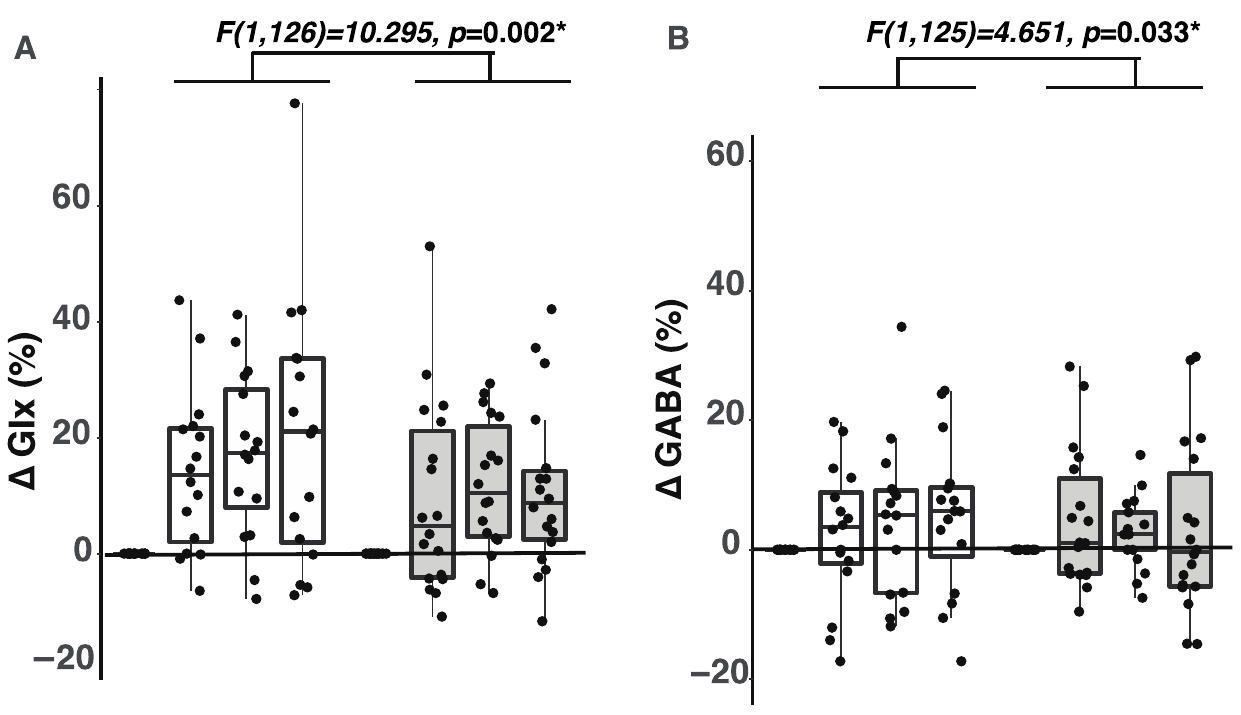
Figure 1. Task-related changes in Glx and GABA content. Open white bars represent the CONTROL group and grey bars represent the ADHD group. In each group, three bars are shown as ΔGlx or ΔGABA increases in the auditory, Stroop, and Flanker tasks respectively. ( A ) Glx changes during the tasks (ΔGlx) are shown in percentage. ΔGlx were computed using the following formula: ΔGlx = (Glx task - Glx non-task )/Glx non-task × 100%. ( B ) GABA changes during the tasks (ΔGABA) are shown in percentage. ΔGABA were computed using the following formula: ΔGABA = (GABA task - GABA non-task )/GABA non-task × 100%. In both figures, dots represent the data points from individual subjects. The upper boundary of an individual box represents the 75th percentile and the lower boundary repre- sents the 25th percentile of the value for an individual block. The horizontal line within the box represents the median in a respective block. Asterisks represent significant changes in Glx or GABA content between ADHD and CONTROL groups at the p level of 0.05.